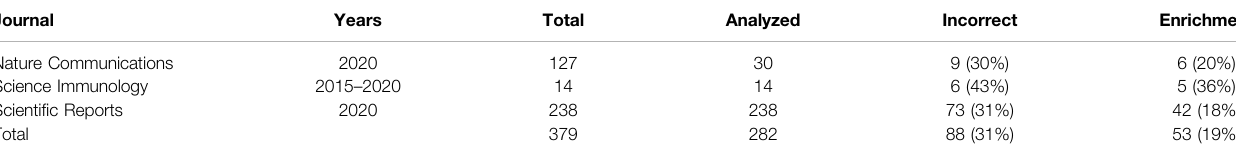
TABLE 2 | Results of the informal literature survey. We searched for papers using Google Scholar and the keywords “ venn diagram ” and “ differential expression. ” Journal, journal title; Years, publication dates; Total, total number of papers found using the search phrase; Analyzed, total number of papers which have been analyzed for correctness; Incorrect, total number (percentage) of papers in which the Venn diagram was combined with comparing signi fi cance to non-signi fi cance; Enrichment, total number (percentage) of papers which combined the Venn diagram with a gene set enrichment